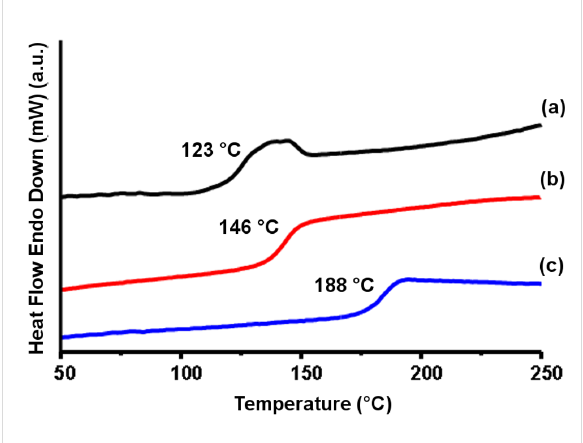
Figure 6: DSC results of the precursor oligomer (PSU-2000) (a), and macromonomer, PSU-DA-2000 before (b), and after curing (PSU-DA- 2000 X)